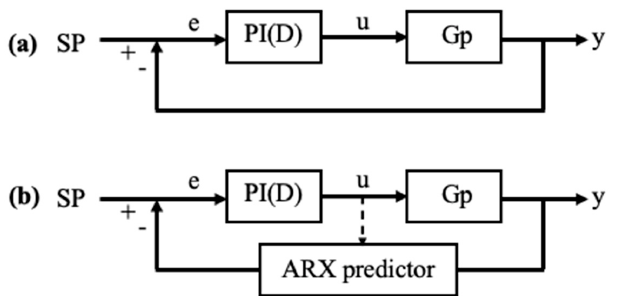
Figure 5. The two feedback control configurations: ( a ) standard feedback control, ( b ) with prediction of more frequent values.